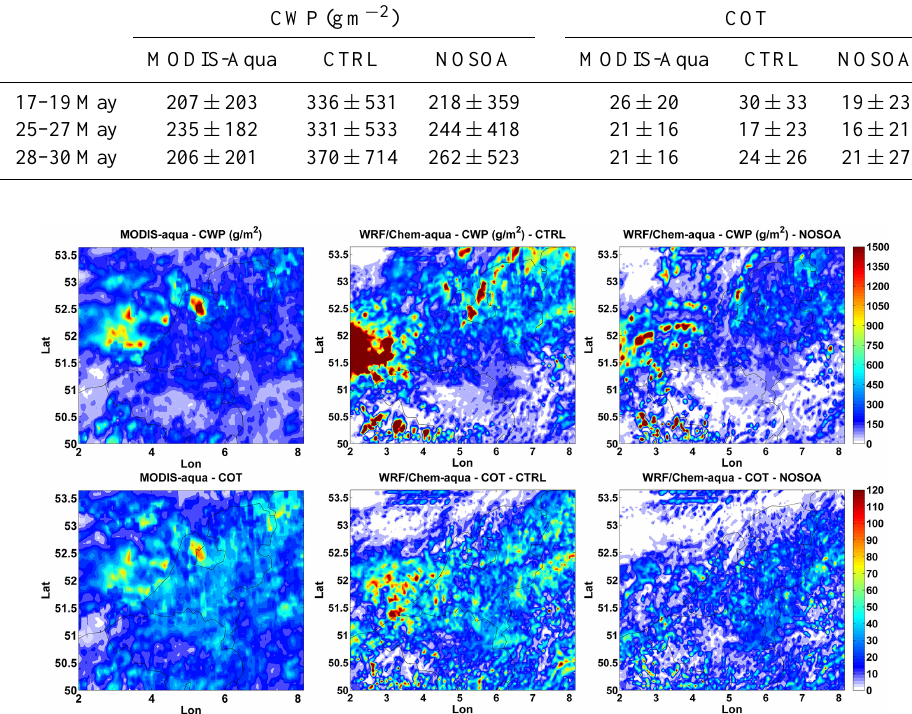
Figure 14. As in Fig. 12, but for clouds in mixed